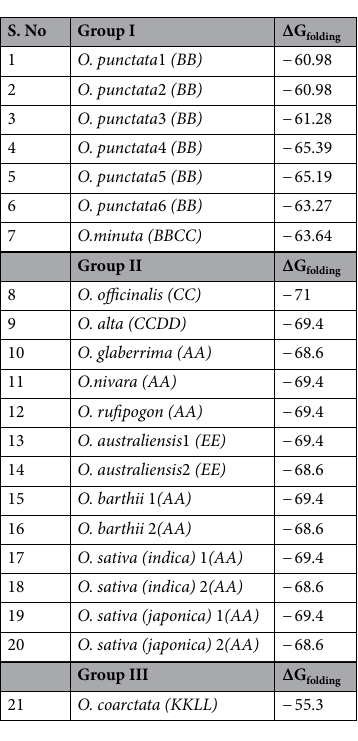
Table 2. Free energy of folding (ΔG folding ) for the secondary structure of pre-